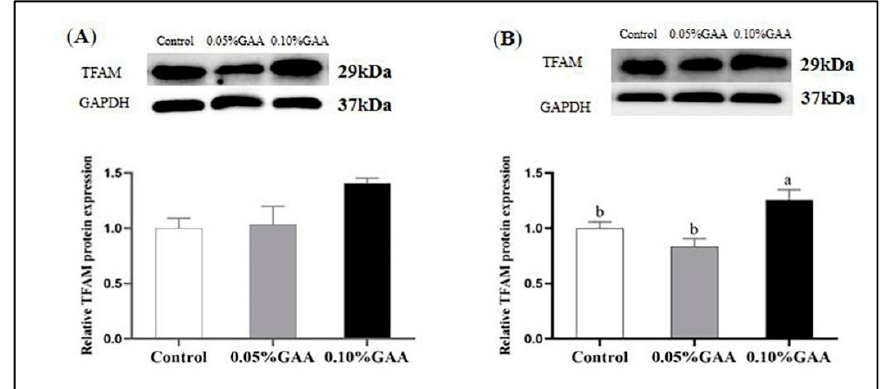
Figure 6. Effects of guanidinoacetic acid supplementation on the protein expression of TFAM of longissimus thoracis muscle ( A ) and semitendinosus muscle ( B ) in finishing pigs. Means with different letters differ significantly ( p < 0.05). Values are presented as the mean ± SEM ( n = 5). Control: Finish- ing pigs were fed a basal diet; 0.05% GAA or 0.10% GAA: Finishing pigs were fed a basal diet sup- plemented with GAA at 500 or GAA at 1000 mg kg − 1 ; TFAM: Mitochondrial transcription factor A.